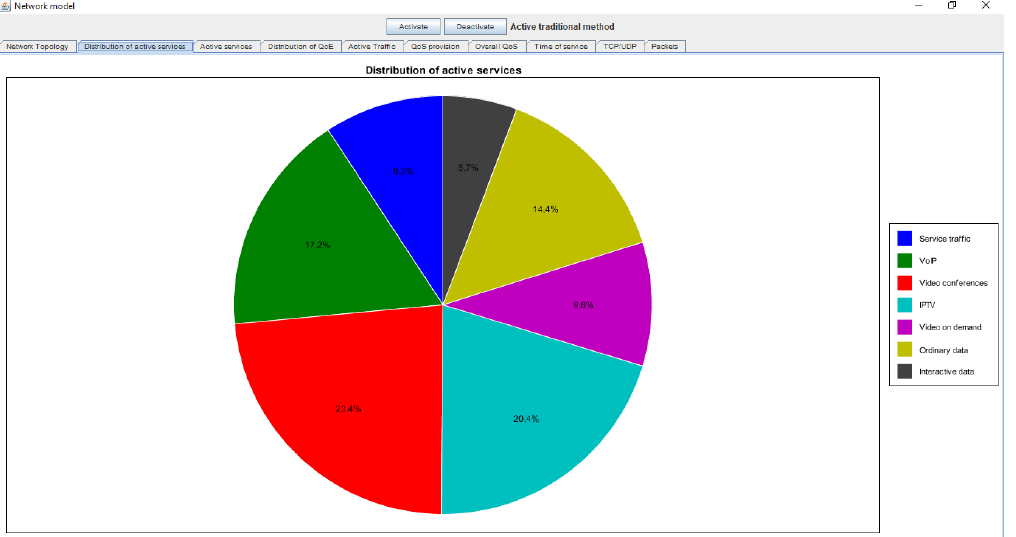
Figure 21. The distribution of network services relative to simulation time.